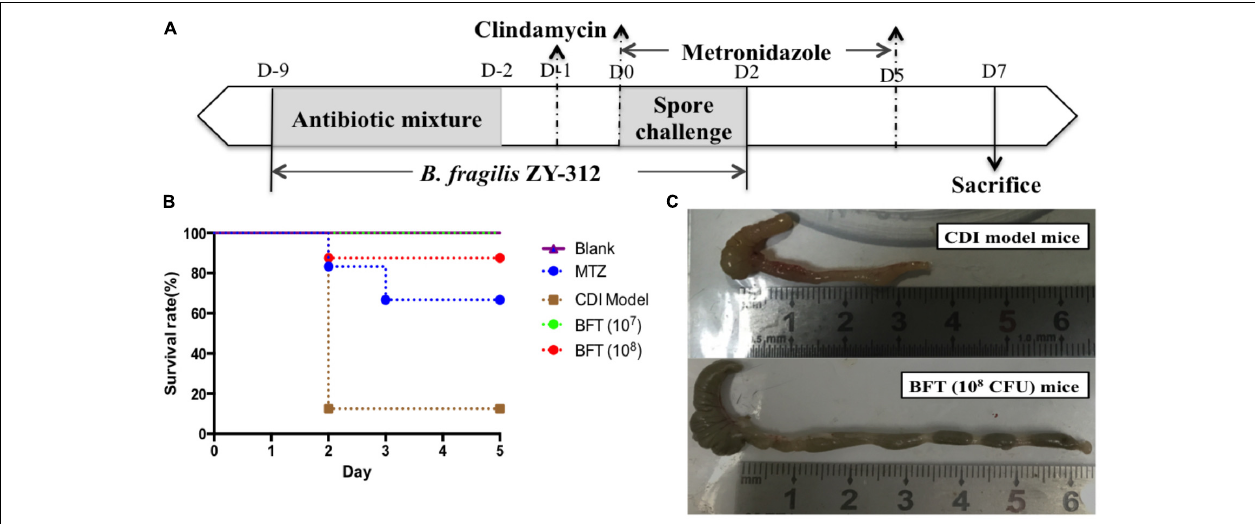
FIGURE 1 | Bacteroides fragilis ZY-312 prevents CDI-associated death. (A) Experimental design for B. fragilis ZY-312 prophylactic treatment of the CDI model mice. The first step of inducing the CDI mouse model was to use a large dosage of antibiotics to disrupt the normal gut microbiota. From D –9 to D –2, drinking water with antibiotics including kanamycin (0.8 mg/mL), gentamicin (0.07 mg/mL), colistin (0.1135 mg/mL), metronidazole (0.43 mg/mL), and vancomycin (0.09 mg/mL) was offered to male C57BL/6 mice (6–8 weeks old, n = 6–8). Clindamycin (10 mg/kg) was intraperitoneally injected the day (D –1) after the cessation of drinking water with antibiotics. Then the mice were orally challenge with 3 × 10 8 cfu of Clostridium difficile VPI 10463 spores from D0 to D2. To explore the prophylactic effects of B. fragilis on preventing C. difficile -associated diseases, 1 × 10 7 or 1 × 10 8 cfu/day B. fragilis were given, respectively, to CDI model mice from D –9 to D2. Metronidazole (1 mg/day) was given orally from D0 to D5, as the positive control. (B) Survival rates of mice in the Blank, MTZ (Metronidazole treated), CDI model, and BFT ( B. fragilis treatment) groups. (C) Visual observations of colon tissues from CDI model mice (top) and BFT (10 8 cfu) mice (means ± SEM; n = 6–8 per group).